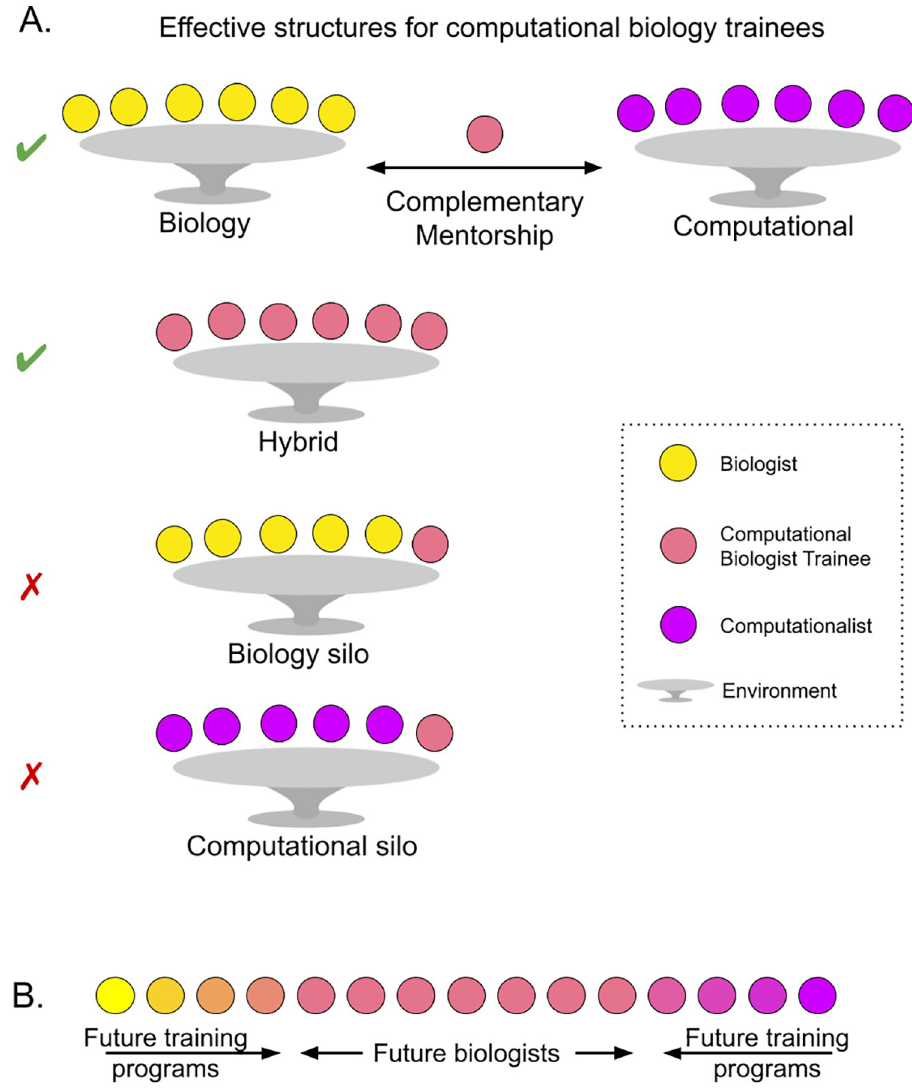
Fig 3. Promoting healthy computational biology environments and training programs will empower future biologists. (A) Existing biology and computational labs can cooperate to provide complementary mentorship to computational biologists, and hybrid labs can provide sufficient support. Institutions must provide oversight to ensure that ill-equipped labs have trainees’ career goals in mind and do not view them as inexpensive labor. (B) Computational biology programs are at an advantage to provide necessary training to forge the biologists of the